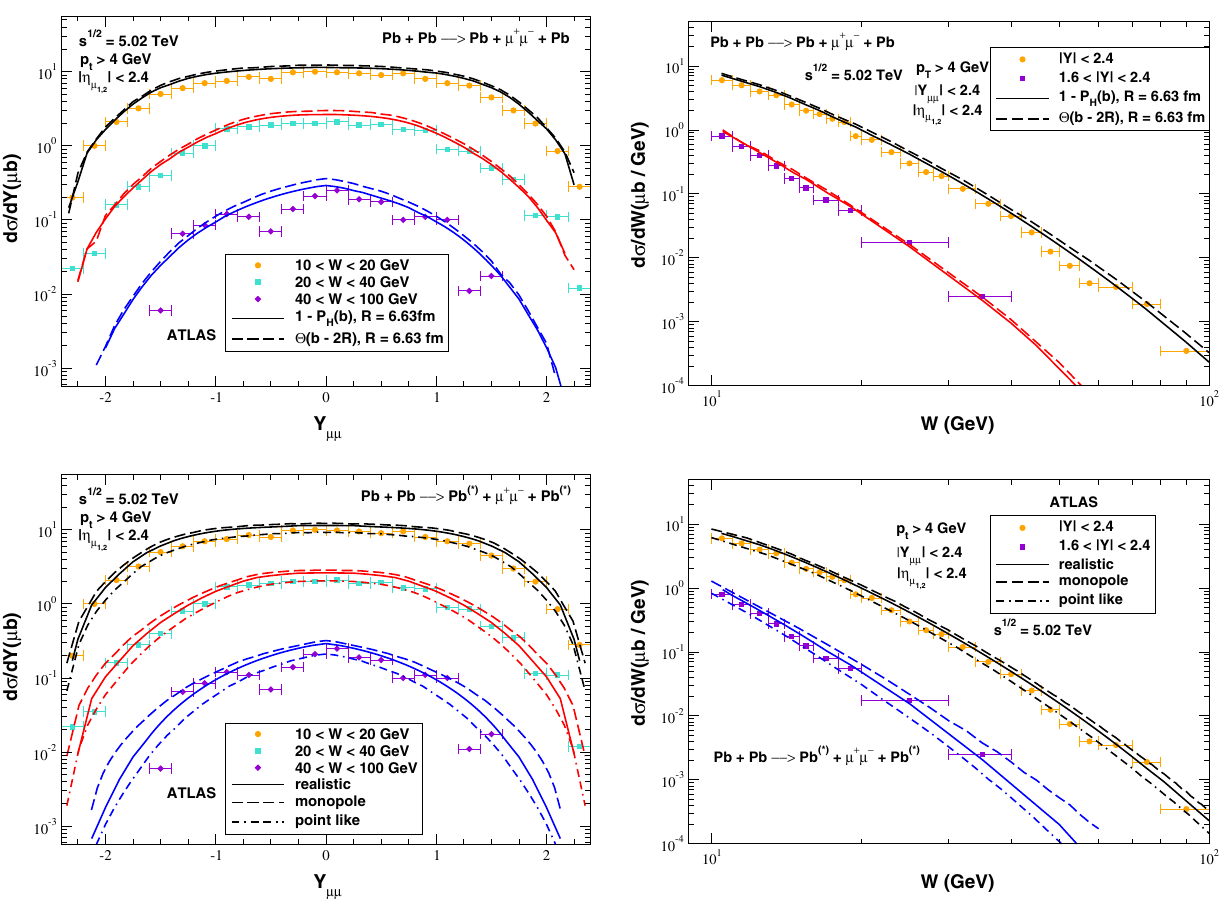
Fig. 4 Rapidity and invariant mass distributions for the exclusive μ + μ − production by γγ interactions in PbPb collisions at TeV. Preliminary experimental data from the ATLAS Collaboration